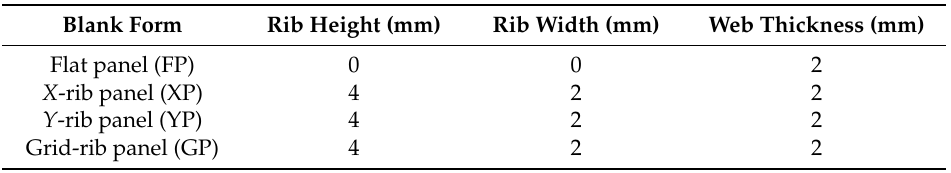
Table 2. Original sizes of the four panels blanks.